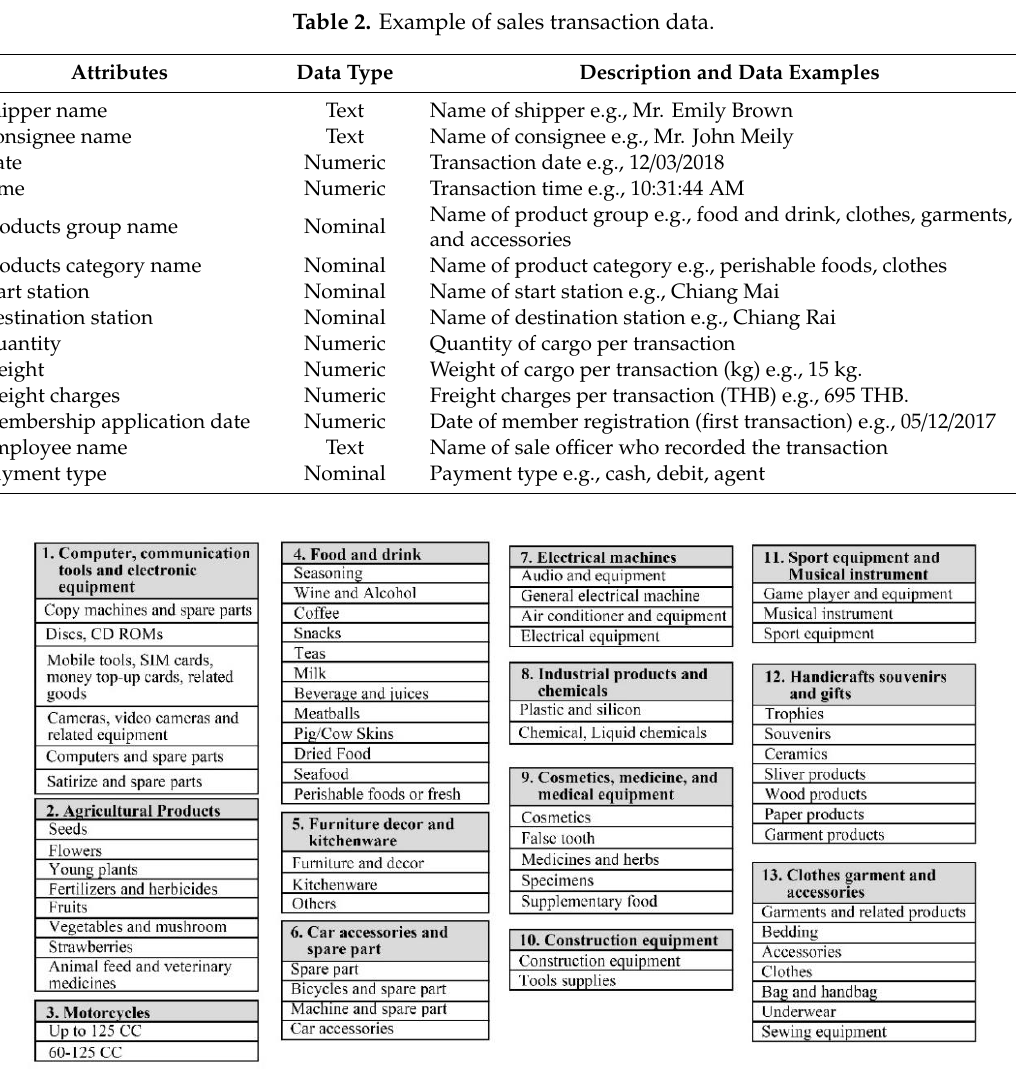
Figure 3. Product groups and items.